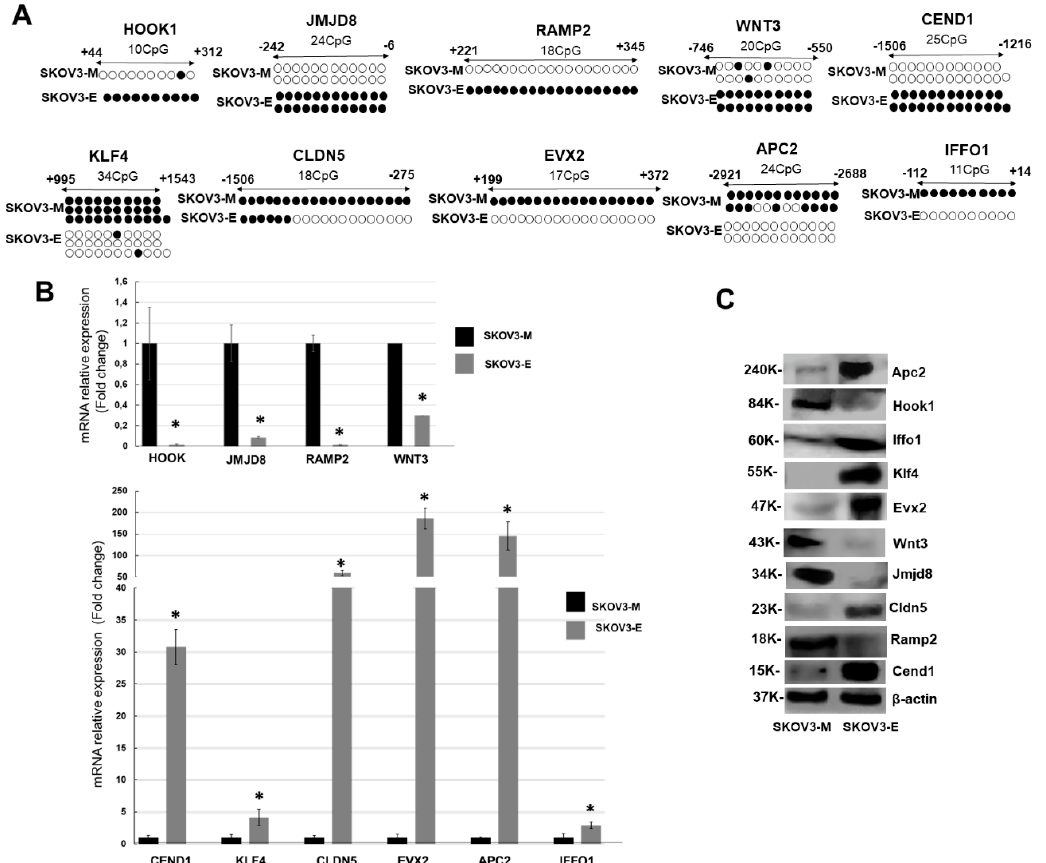
Figure 2. Validation of methylation status and the corresponding expression levels of the ten RRBS-retained genes in the SKOV3-LY75-related EMT model. ( A ) Bisulfite-sequencing PCR (BSP) analysis of the methylation status of selected genes in the SKOV3-M (sh-control) and the SKOV3-E (sh3-8 clone). Filled circles represent methylated CpGs and open circles represent unmethylated CpGs. The indicated positions on the CpG plots represent the number of nucleotides stretching upstream ( + ) and downstream ( − ) of the transcription initiation (ATG) codon for each gene analyzed. ( B ) Quantitative PCR analysis of the mRNA expression profiles of the ten selected genes in SKOV3-M and SKOV3-E cells. In all analyses, mRNA levels were displayed as relative to their expression levels in SKOV3-M cells and normalized to the ribosomal 18S (control) gene expression. Error bars represent SD; * p < 0.05. ( C ) Western blot analysis of the protein expression levels of the 10 selected genes in SKOV3-M and SKOV3-E cells. β -Actin was used as a loading control.